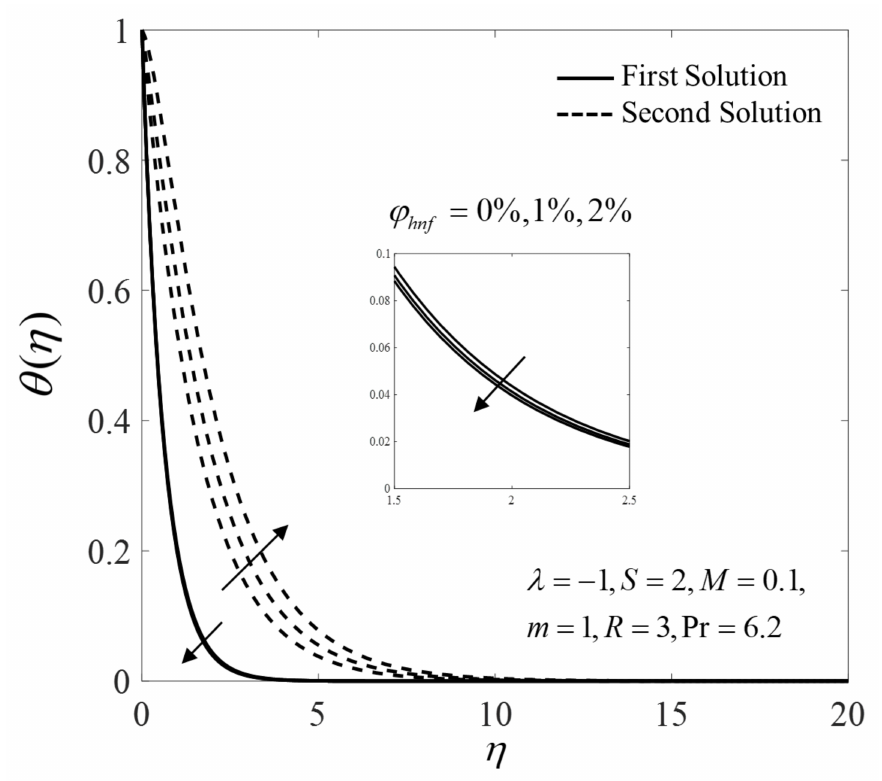
Figure 13. Temperature profiles θ ( η ) for different values of ϕ hnf